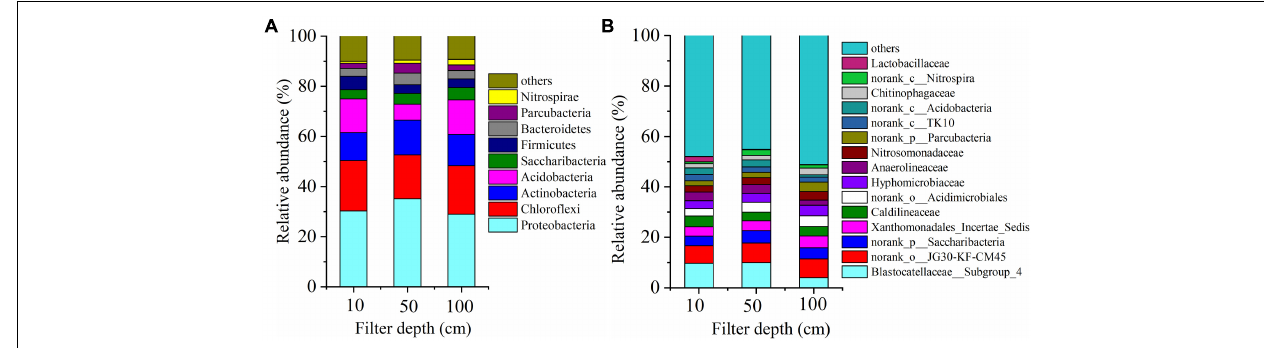
FIGURE 5 | Change of microbial community composition along the DN-DBF depth (A) at phylum level and (B) at genus level.